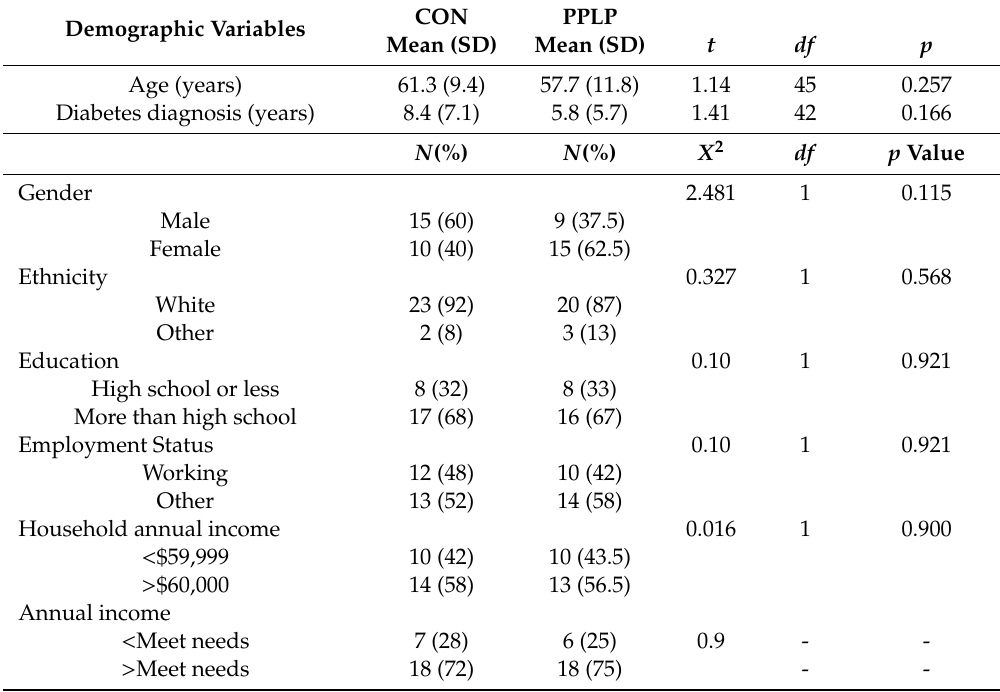
Table 1. Demographic characteristics of